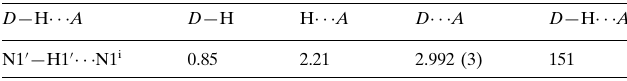
Hydrogen-bond geometry (A˚ , (cid:2) ). D —H (cid:1)(cid:1)(cid:1)